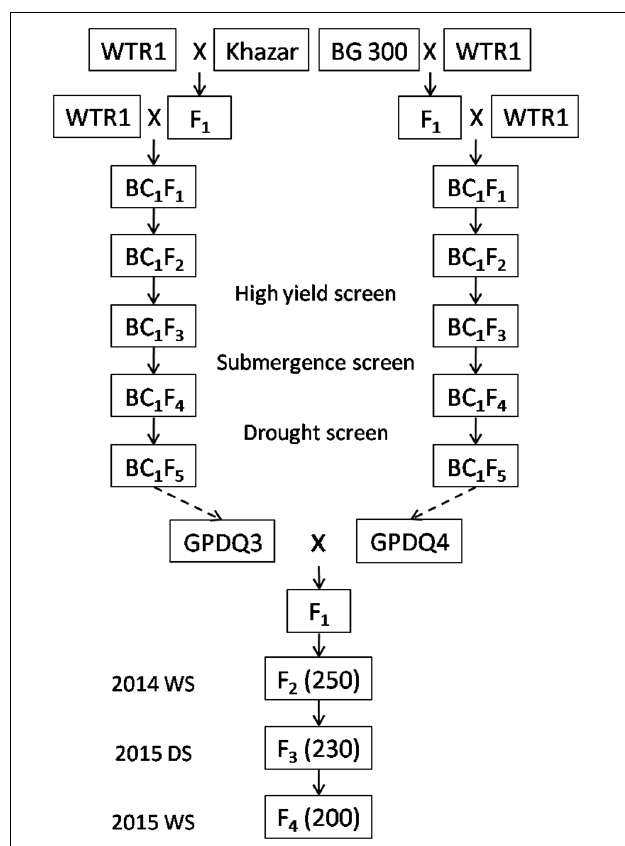
FIGURE 1 | The process of developing 200 F 4 lines by single seed decent from a pyramiding cross between two Weed Tolerance Rice 1 (WTR1) introgression lines. The values in brackets were the number of plants in each generation. WS and DS were wet season and dry season at International Rice Research